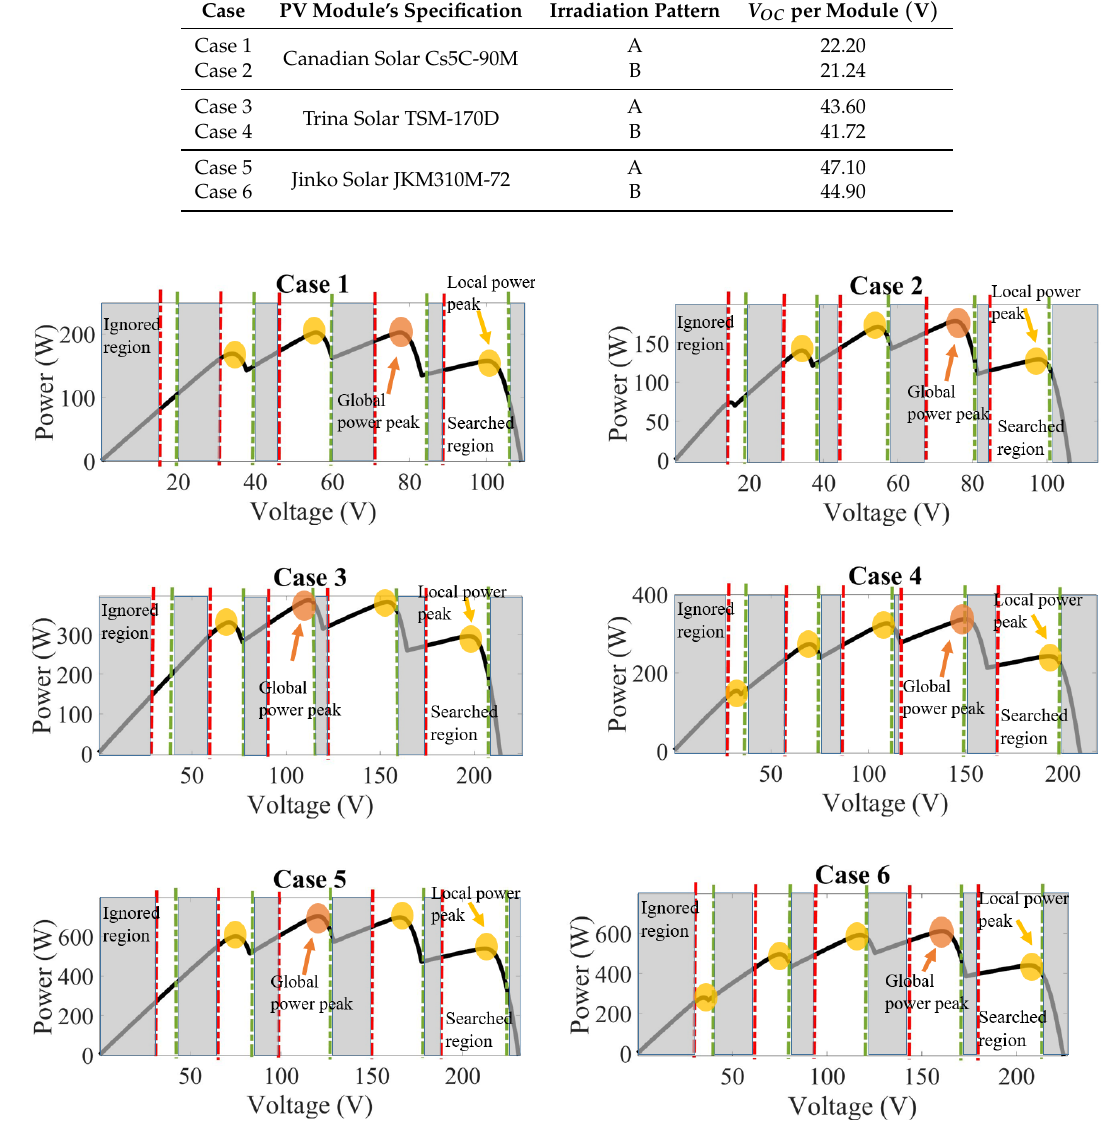
Figure 4. P-V characteristic curves for Cases